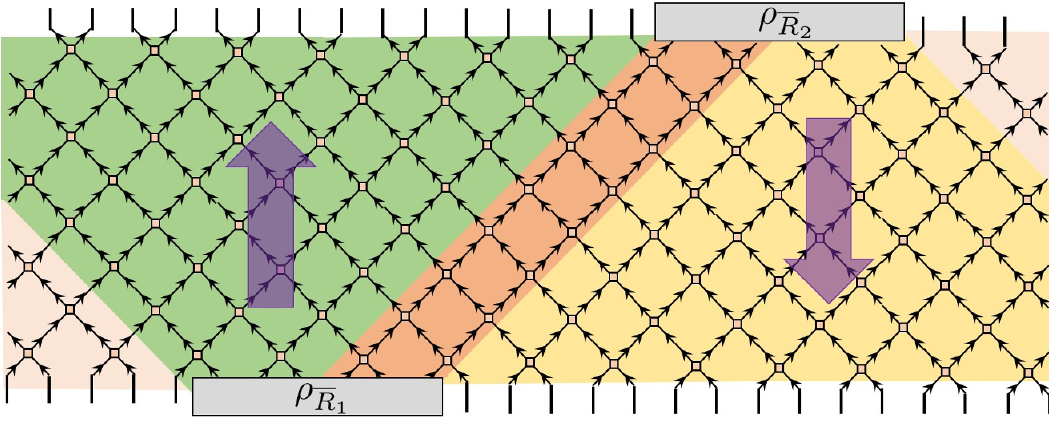
Figure 11 . In a Trotter network with a special initial and (cid:12)nal state, there can be multiple arrows of time, as depicted by the